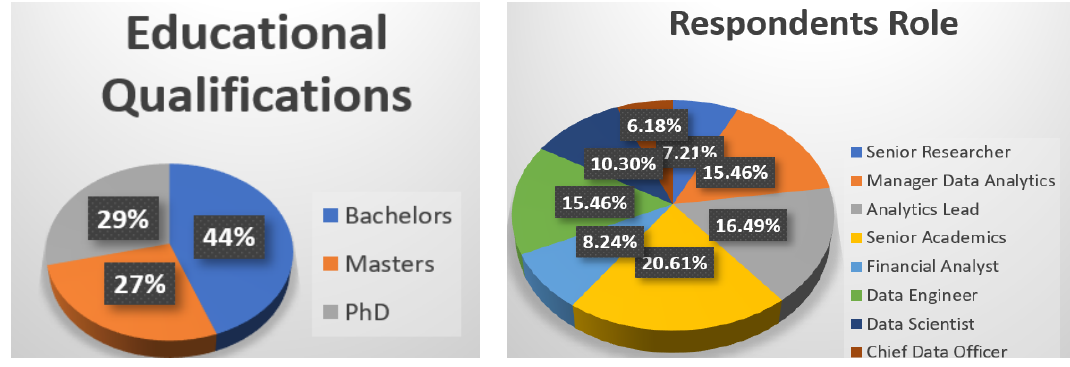
Figure 1. Respondents’ roles in organisations.